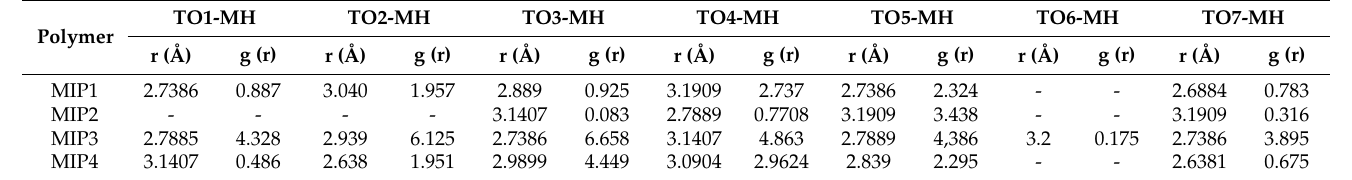
Table 1. RDF of oxygen atoms of SLX with hydrogen of HEMA in range of hydrogen bonding radii.